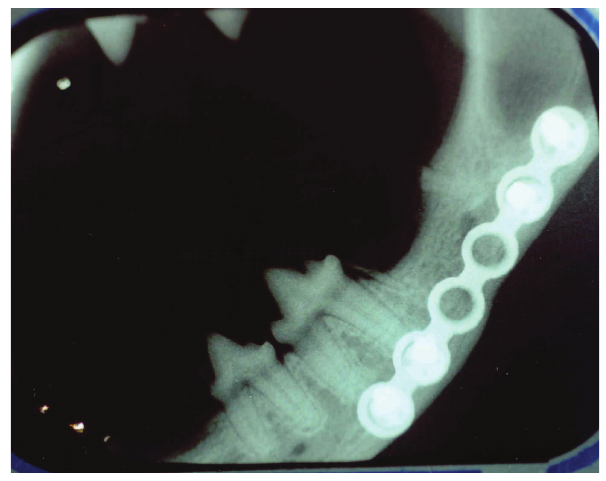
FIGURE 10 - Histologic section of the operated hemimandible shows that the mandible/graft interface was bridged by woven bone. Mineralised bone: green. Osteoid: orange. Cat 21 of Group 2 specimen. (Masson- Goldner -